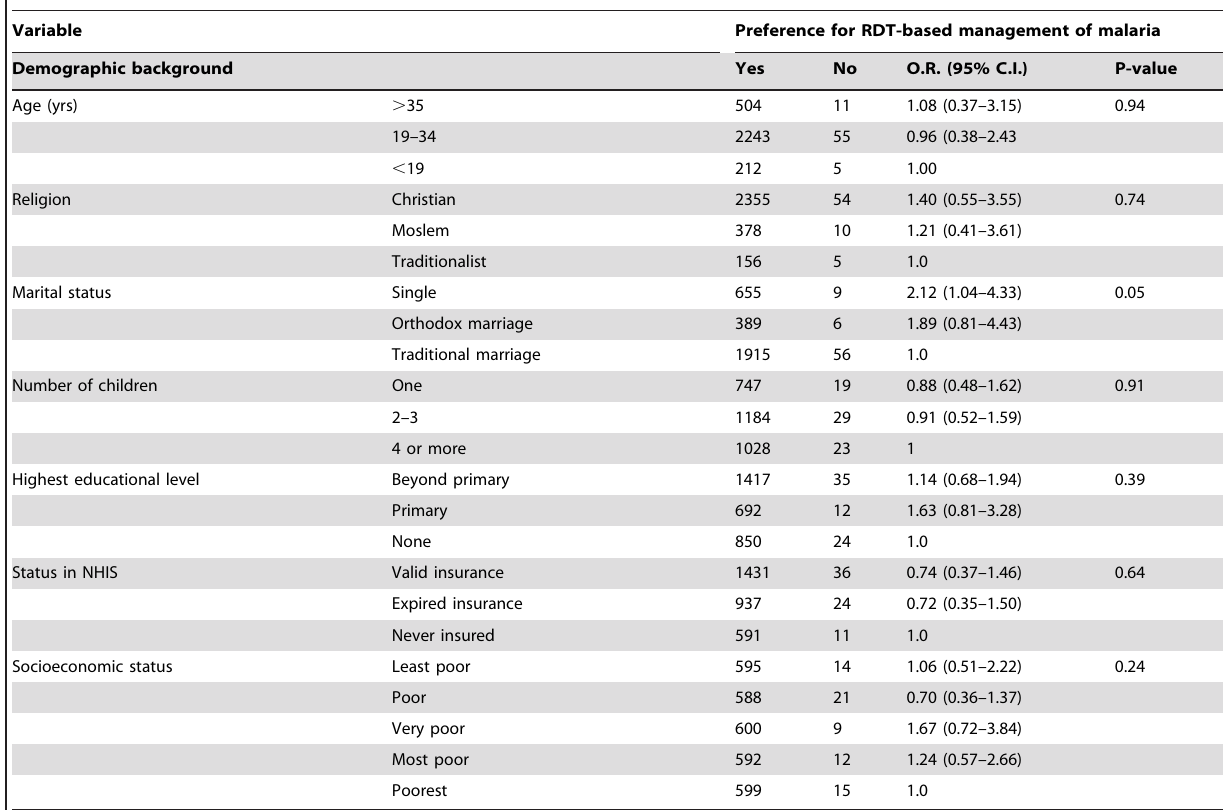
Table 1. Sociodemographic background of caregivers and the preference for RDT-based management of malaria.